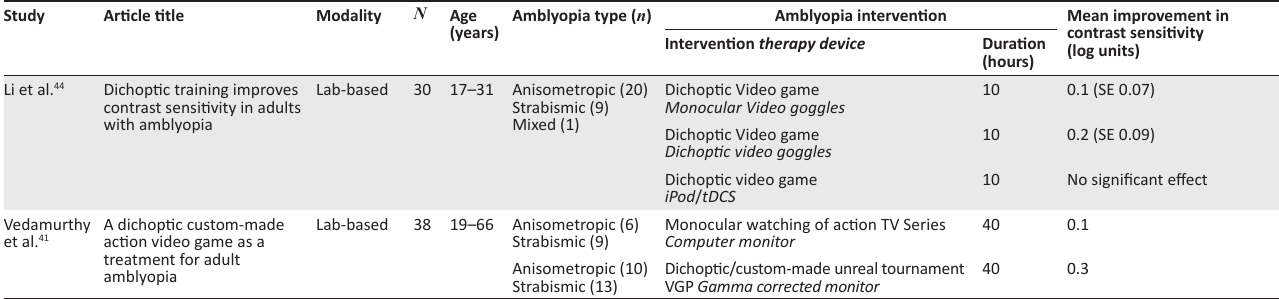
TABLE 3: Dichoptic therapy and contrast sensitivity improvement in anisometropic, strabismic and mixed